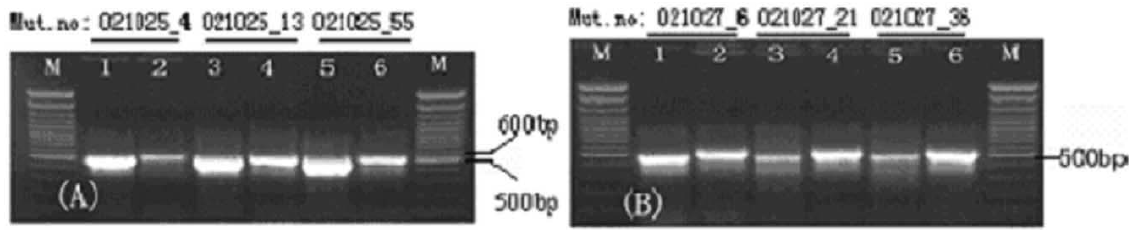
Figure 3 - High-fidelity PCR amplification of two regions of rpoB of Rif r mutants induced by either 10 keV nitrogen ion beam (A) or 60 Co-gamma ray (B).M:marker(GeneRuler TM 100bpDNAladderplus,MBI).Mutantnumbers(Mut.no.)areshownabovetheelectrophoresisbands(A)(B)1,3,5:region A of the corresponding mutant (492 bp in size); (A) (B) 2,4,6: region B of the corresponding mutant (530 bp in